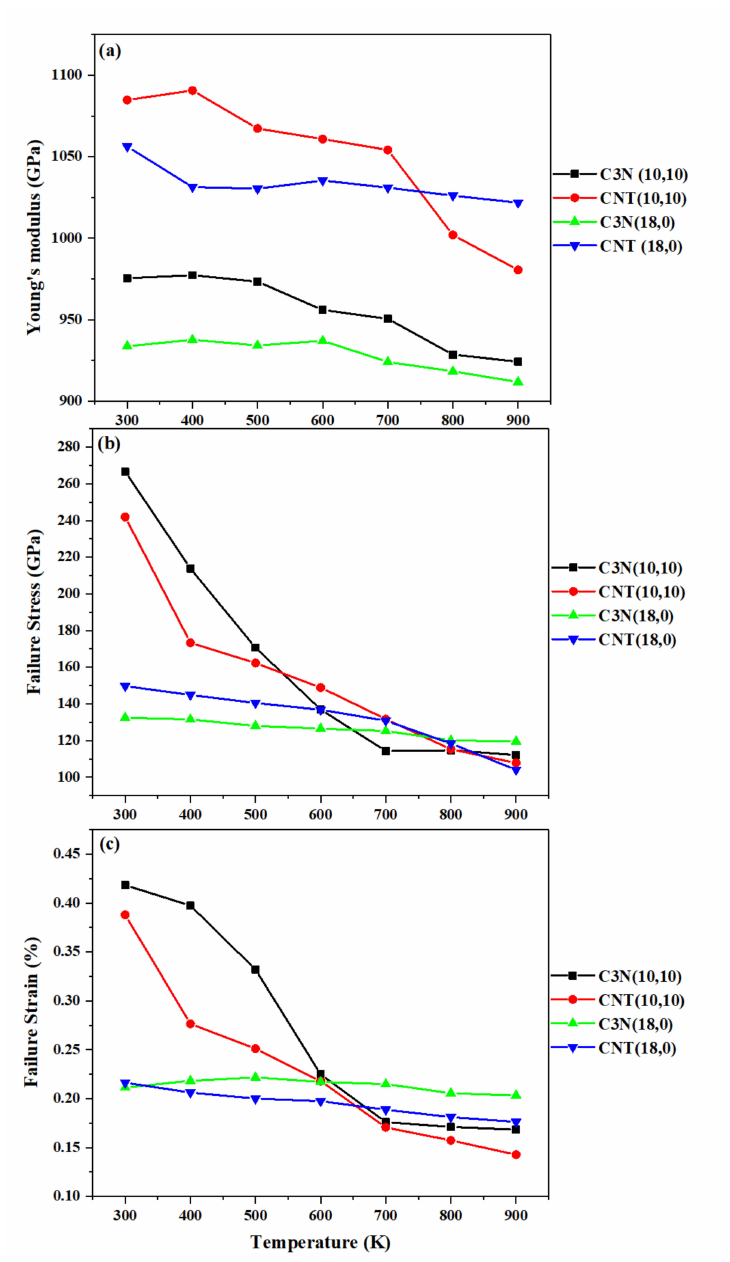
Figure 5. ( a ) Young’s modulus, ( b ) failure stress, and ( c ) failure strain of (10,10) and (18,0) SWC 3 NNTs and SWCNTs under uniaxial tensile tests, as a function of